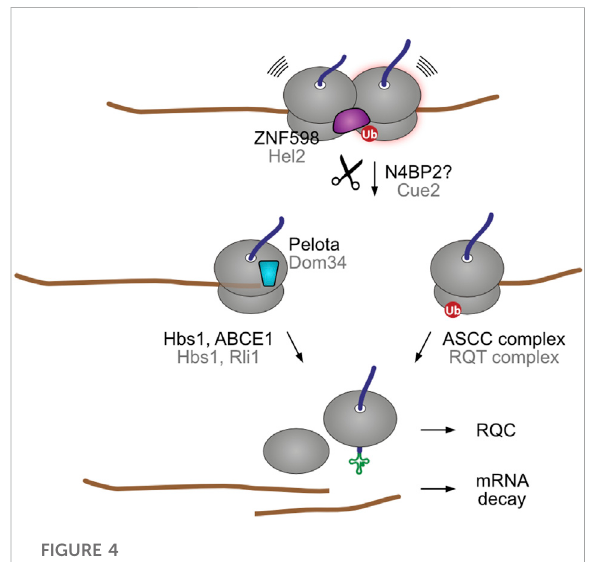
FIGURE 4 Endonucleolytic cleavage can result in secondary stalling. In yeast, nematodes, and possibly in humans, the ribosome collision sensorHel2recruitstheCue2endonuclease(NONU-1inworm)to cleave the encoding mRNA in the vicinity of the ribosome collisionsite.Theubiquitinated stalledribosomeisthensplitbythe RQT ribosome rescue complex. The trailing ribosome subsequently stalls at the new 3 ′ end of the resulting truncated mRNA. This exposes an empty A site that is recognized by the Dom34 factor, which recruits the Hbs1-Rli1 factors for ribosomal splitting.Although humanshaveaCue2homolog(N4BP2),itisnot yetclearifit engages incollision-dependentmRNA decay. Human and yeast homologs are labeled in black and grey,